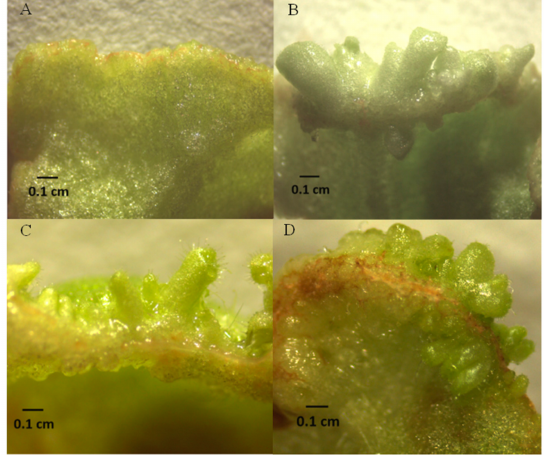
Figure 10. Leaf regeneration test of tobacco plants overexpressing chrysanthemum KNOX genes (( A ) shows the edge of wild-type tobacco leaf tissue after 10 days of tissue culture, ( B ) shows the edge of leaf tissue of tobacco plant overexpressing chrysanthemum CmKNAT1 gene after 10 days of tissue culture, ( C ) shows the edge of leaf tissue of tobacco plant overexpressing chrysanthemum CmKNAT6 gene after 10 days of tissue culture and ( D ) shows the edge of leaf tissue of tobacco plant overexpressing chrysanthemum CmSTM gene after 10 days of tissue culture).